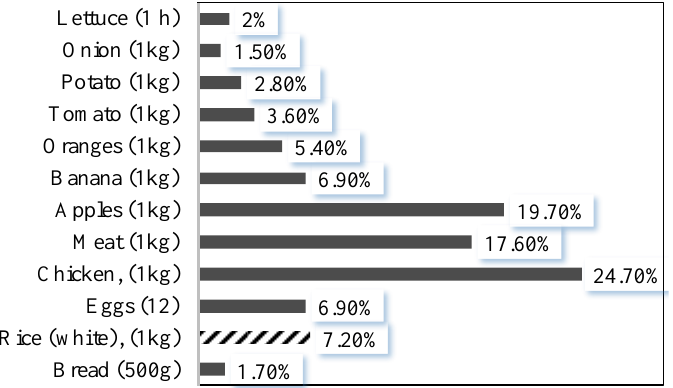
Figure 3. A model of food consumption in India.